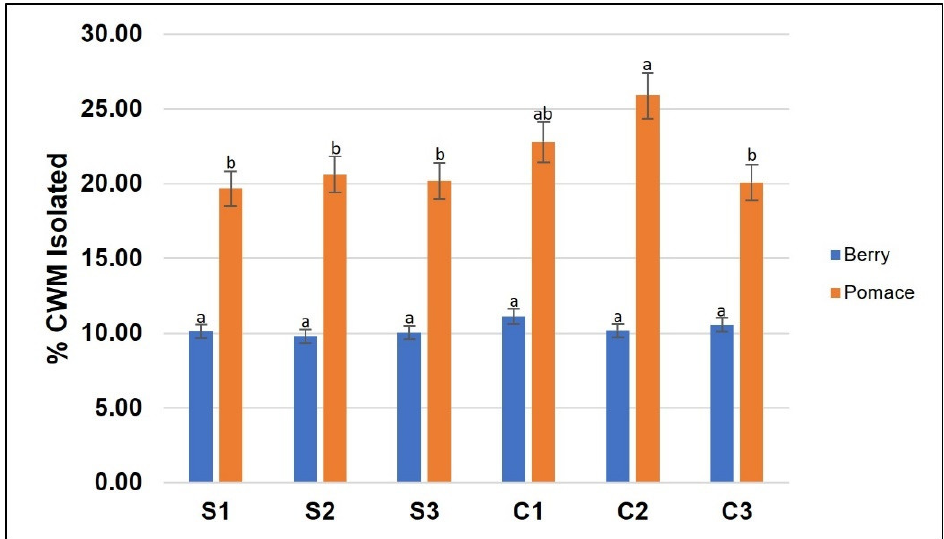
Figure 1. Percentage of CWM isolated from grape and pomace skins. S-Sonoma County, C-Central Coast. Numbers 1, 2, 3 indicate different sites within the same region ( n = 3). Different letters mean significant differences (Tukey’s test, p < 0.05).